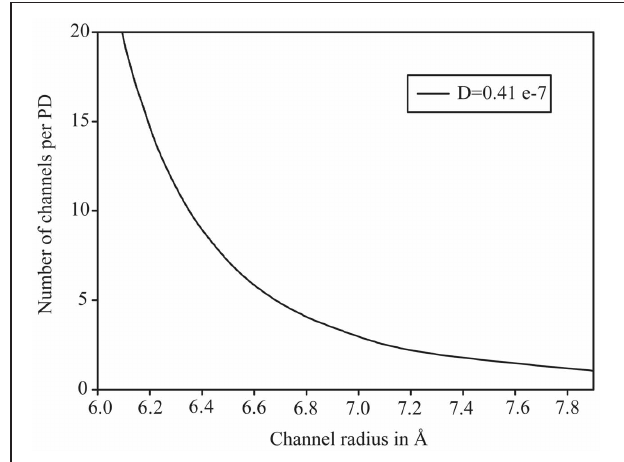
FIGURE 3 | Plot of effective diffusion coefficient for diffusion of fluorescein through plasmodesmata with sub-nano channel configuration. The curve shows at which combination of number of channels and channel radius the experimentally determined value is